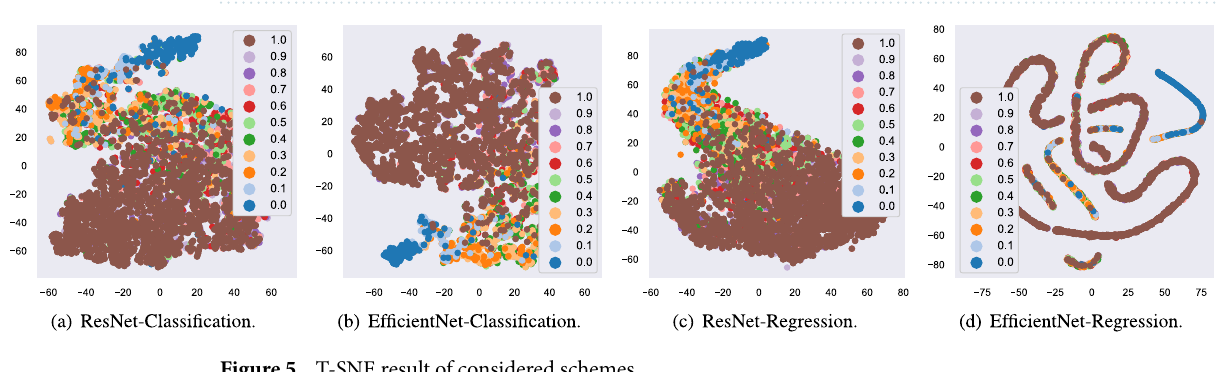
Figure 5. T-SNE result of considered